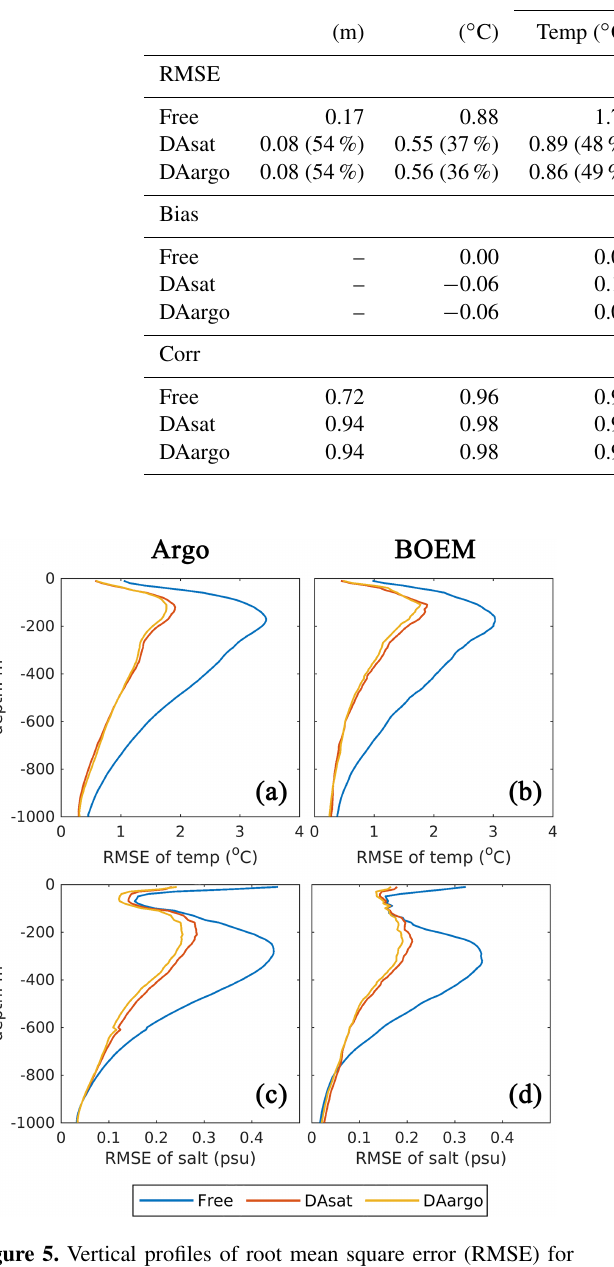
Figure 5. Vertical profiles of root mean square error (RMSE) for temperature and salinity with respect to Argo and BOEM